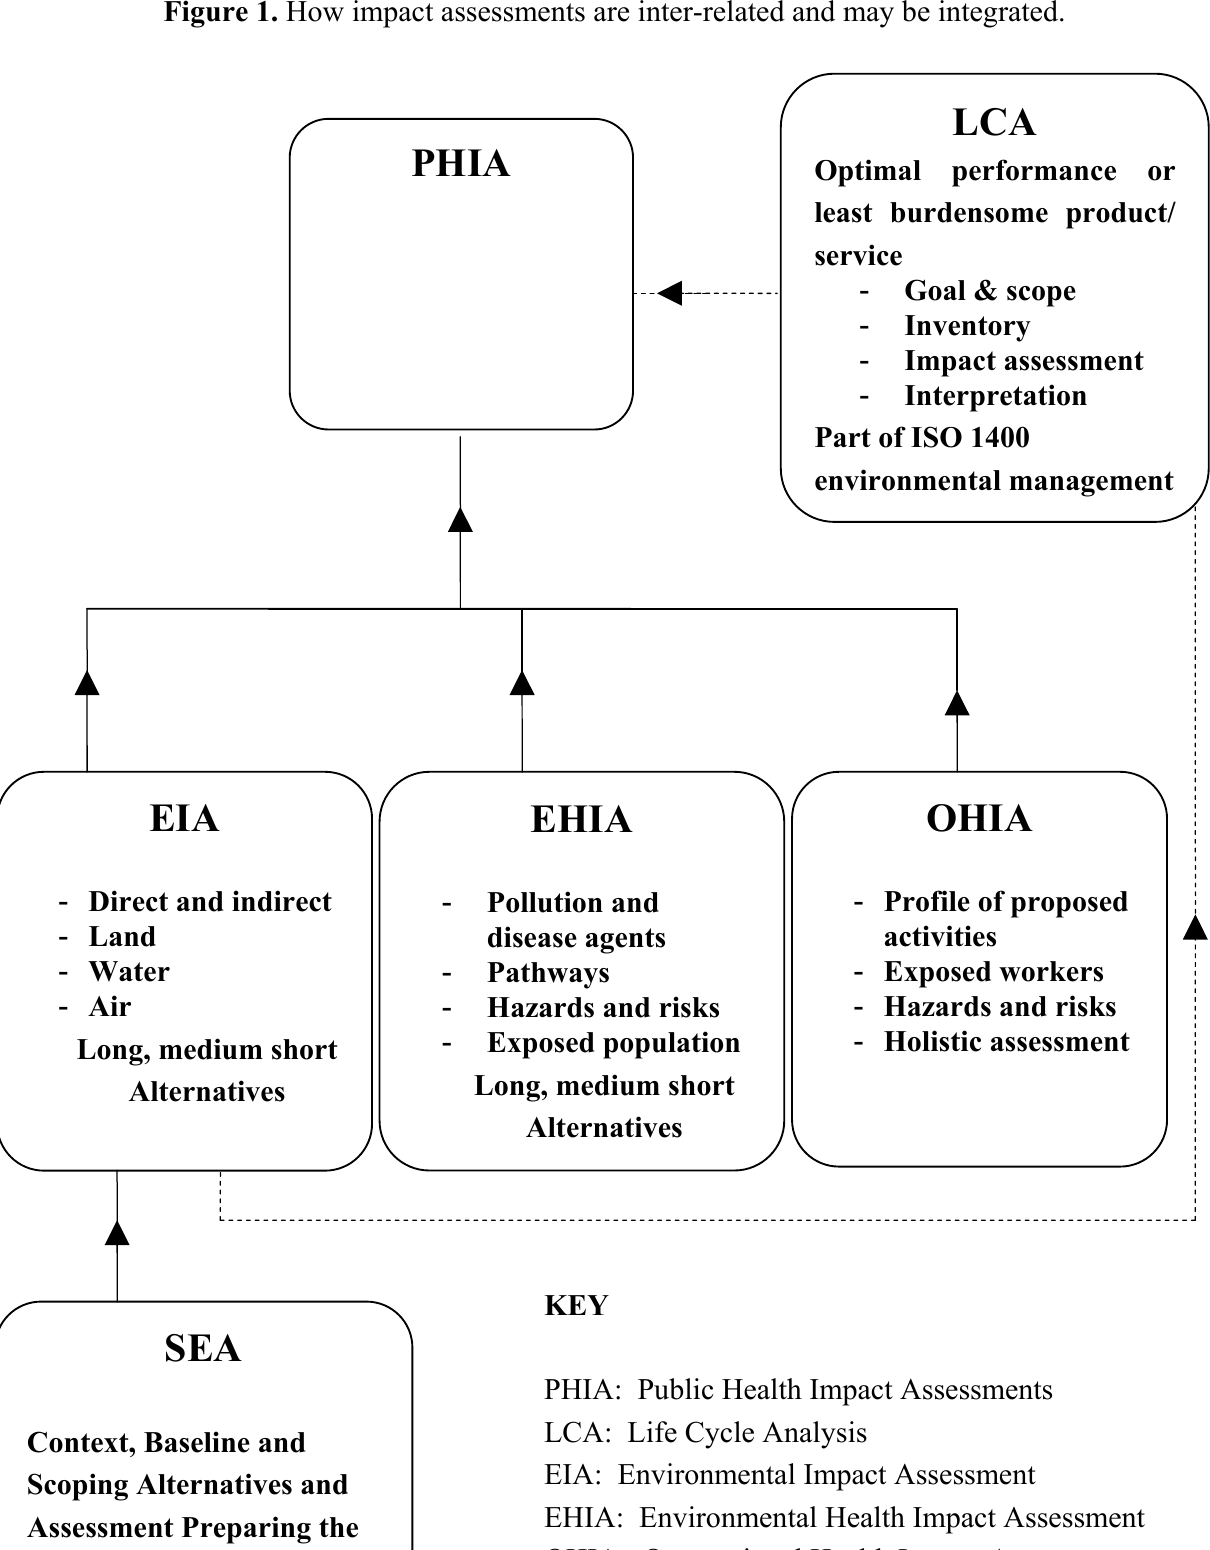
Figure 1. How impact assessments are inter-related and may be